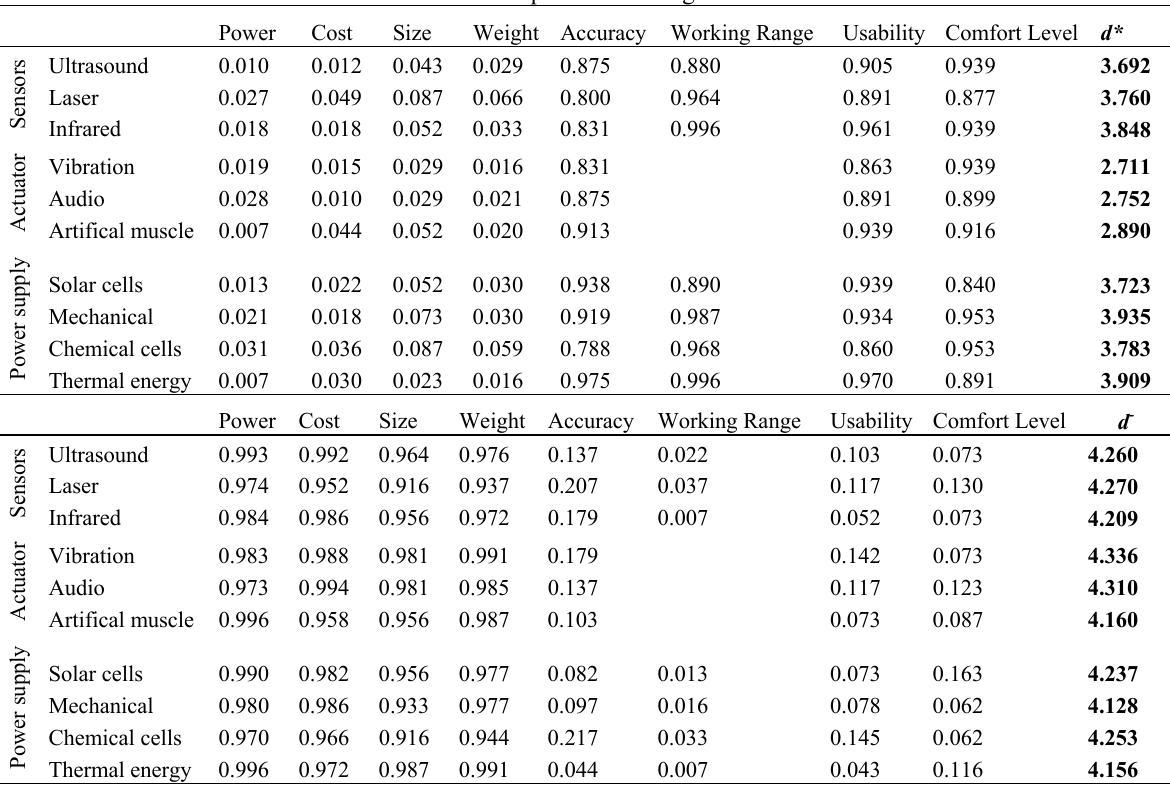
Table 9. Distances to positive and negative ideal